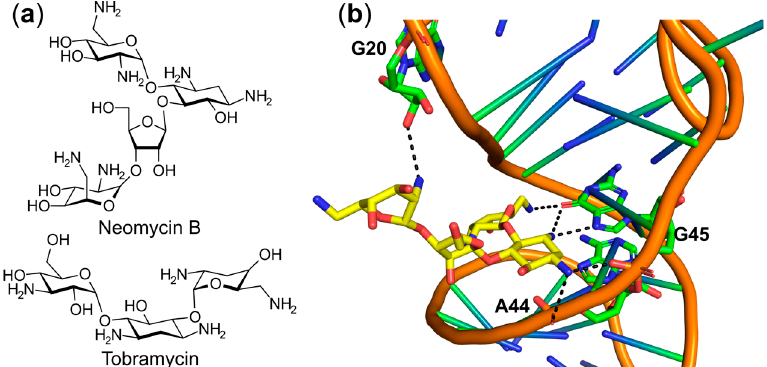
Figure 13. Structures of inhibitors bound to tRNA. ( a ) Chemical structures of aminoglycoside inhibitors targeting tRNA Phe and tRNA Asp ; ( b ) Structure of yeast tRNA Phe bound to neomycin B (PDB entry: 1I9V). The ligand and interacting bases of tRNA Phe are shown as sticks and the C-atoms colored in yellow and green, respectively. tRNA Phe backbone atoms and remaining bases are shown as cartoon